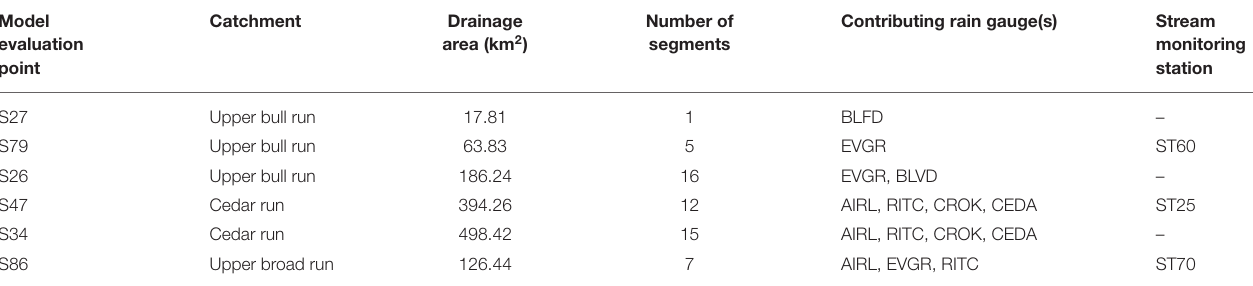
TABLE 1 | Occoquan Watershed characteristics used in the HSPF model. Model